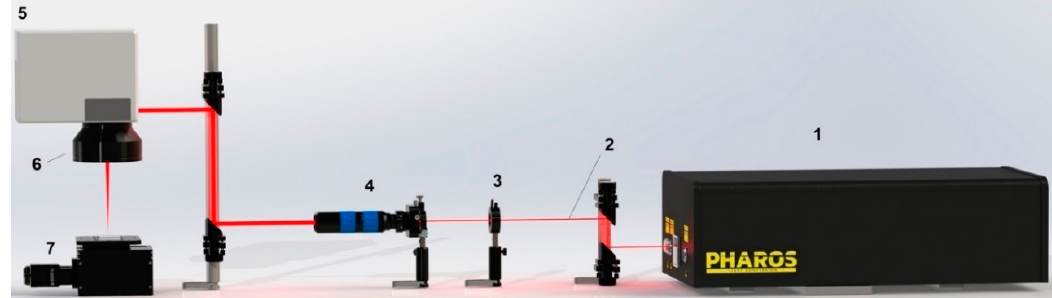
Figure 1. Laser setup for generation LIPSS: 1 —femtosecond laser “Pharos”, 2 —laser beam, 3 —HWP (half wave plate), 4 —expander, 5 —galvoscaner, 6 —F-theta lens, 7 —z-axis motorized stage.